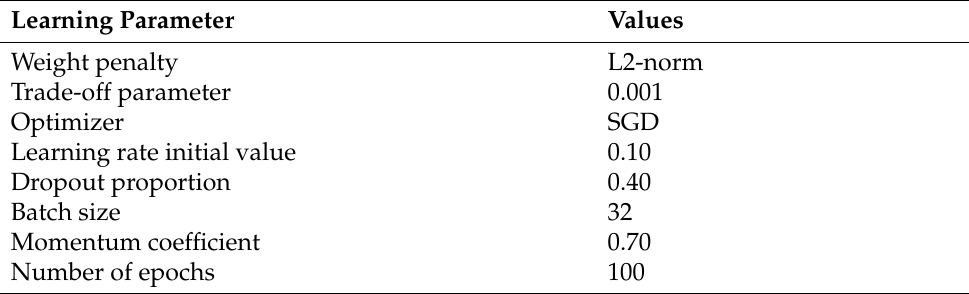
Table 2. Related parameter settings for the model proposed in this